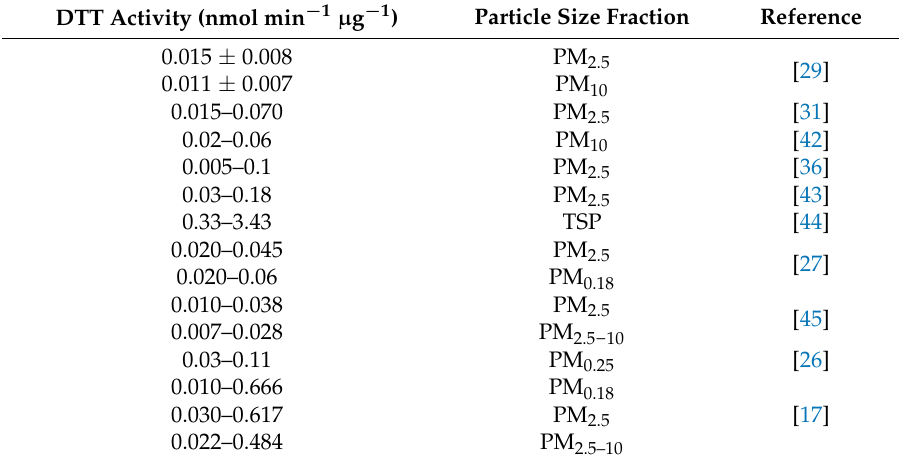
Table 1. Mass-normalized DTT activity of ordinary PM